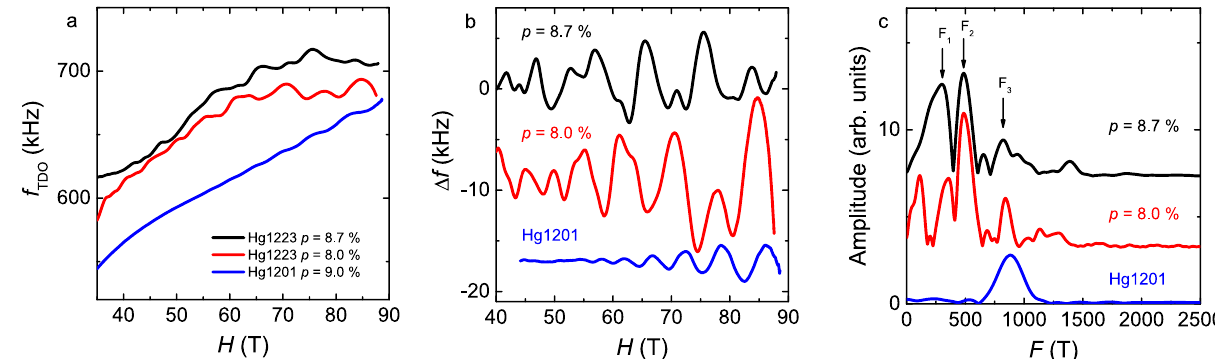
Fig. 1 QO data. a Field dependence of the TDO frequency after the heterodyne circuit at low temperature in the monolayer Hg1201 (blue line) and in the tri- layer Hg1223 at different doping levels (black and red line). b Oscillatory part of the TDO signal after removing a smooth background (spline) from the data shown in panel a . c Discrete Fourier analysis of the oscillatory part of the TDO signal shown in panel b